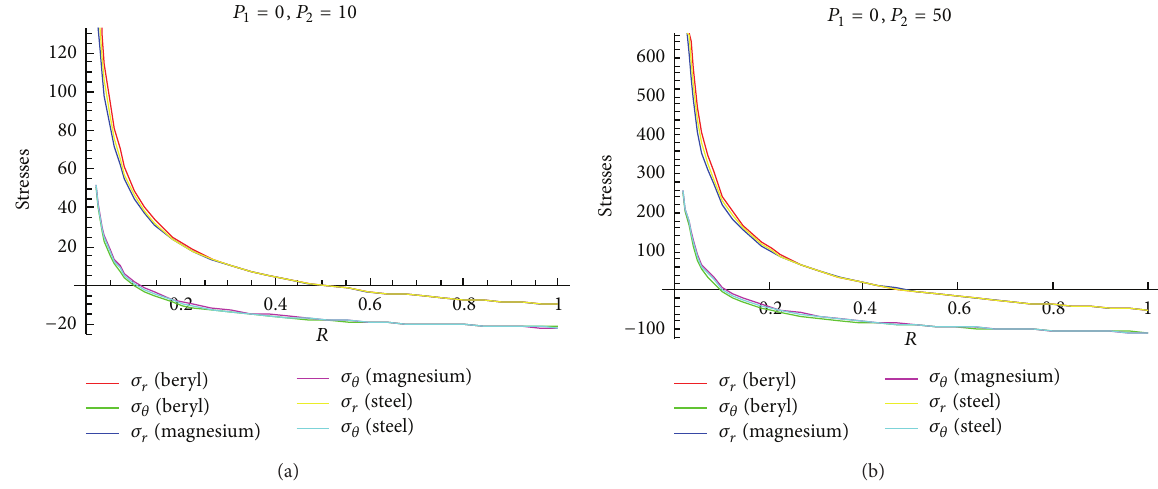
Figure 5: Transitional stresses when external pressure 𝑃 2 = 10 and external pressure 𝑃 2 = 50 (without internal